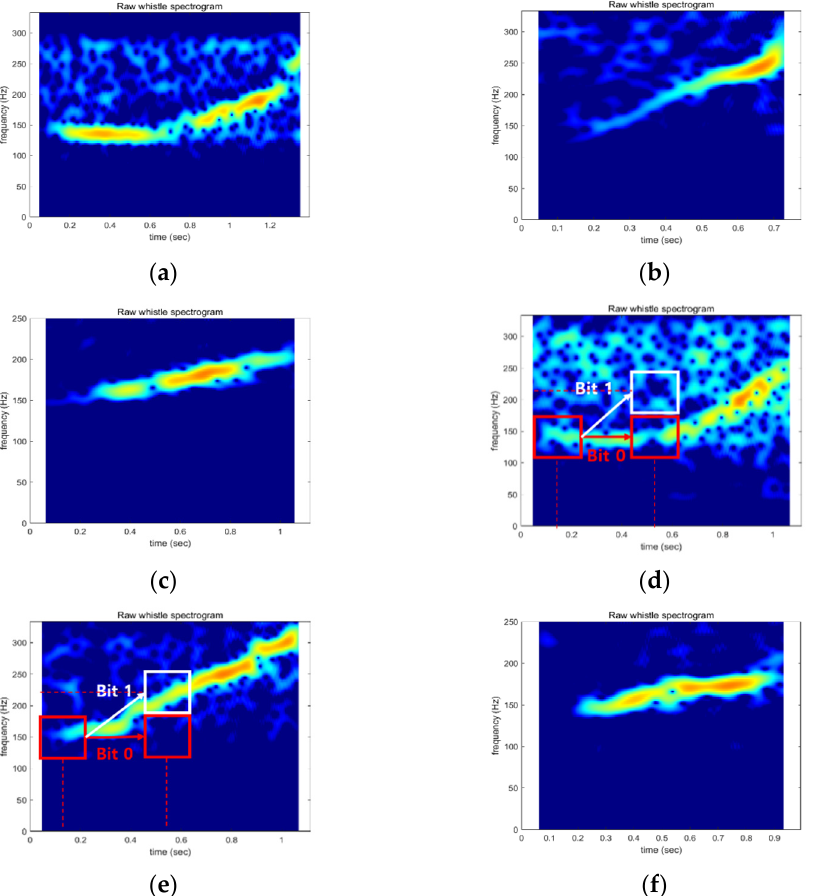
Figure 1. Spectrogram of whistles of the RHW: ( a ), ( d ) Pattern 1; ( b ), ( e ) Pattern 2; ( c ), ( f ) Pattern 3.